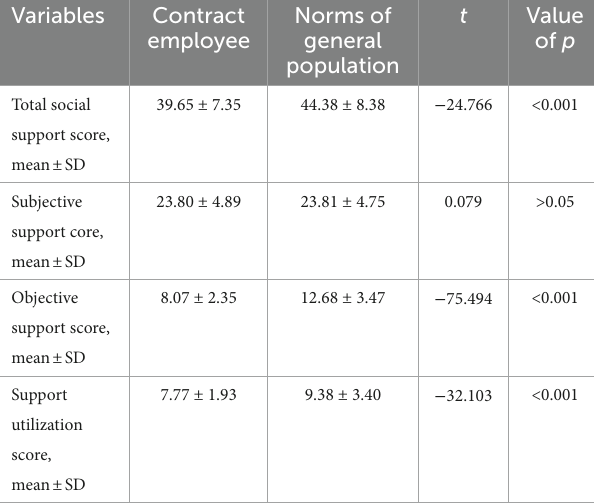
TABLE 3 The difference of social support scores between contract employee and the norms of Chinese general